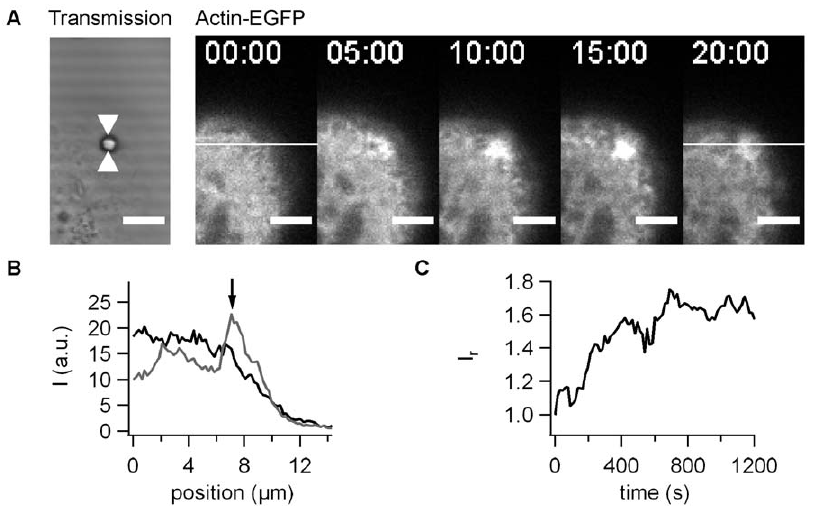
Figure 2. Dynamics of actin-EGFP accumulation with pilus coated beads. A) One confocal plane of actin-EGFP producing epithelial cells was monitored during 20 min. Scale bar 5 m m. B) Intensity plot through the ROI shown in A) at black: 0 min, grey: 20 min post adhesion. C) I r as a function of time for the time lapse in A).